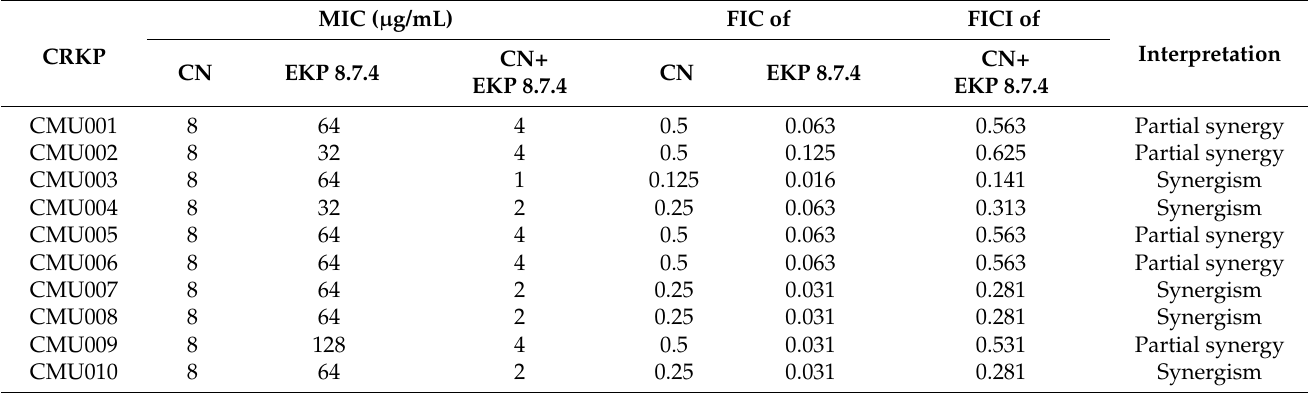
Table 4. Combination effect of gentamicin and EKP 8.7.4 extract against CRKP.